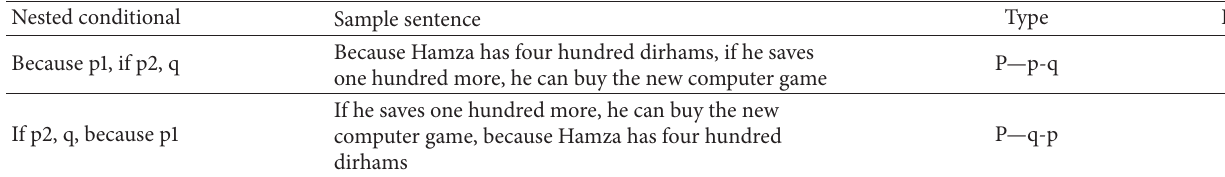
Table 6: Encoding nested conditionals.